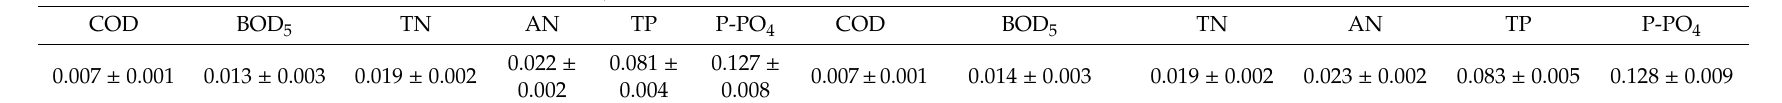
Ratio of Microalgae Biomass to Introduced Organic Compounds